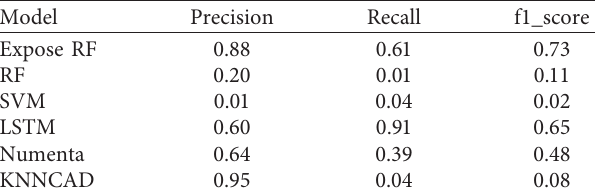
Table 7: Anomaly detector comparation.